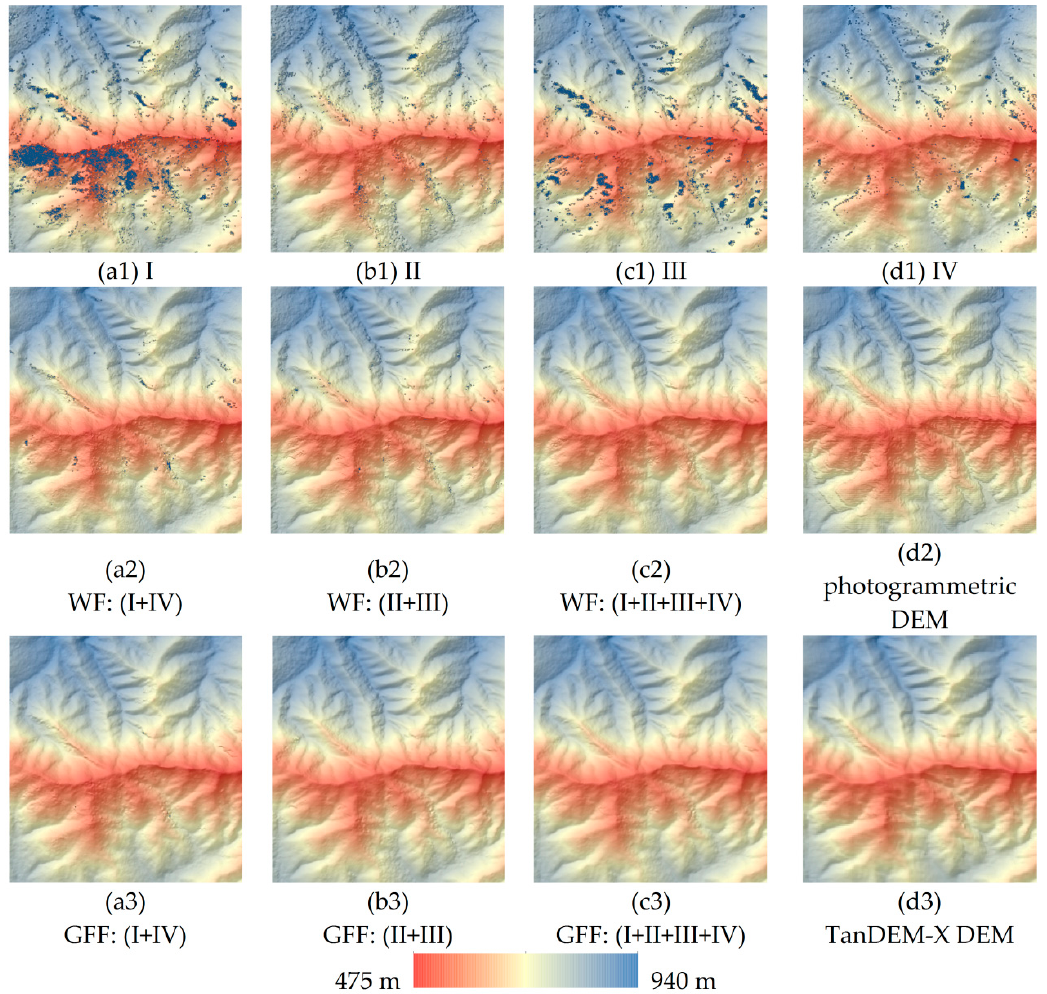
Figure 8. DEM magnifications of the mountainous area. ( a1 – a4 ) correspond to the single-baseline InSAR DEMs I ( B n = 251 m), II ( B n = 157 m), III ( B n = 471 m) and IV ( B n = 237 m),